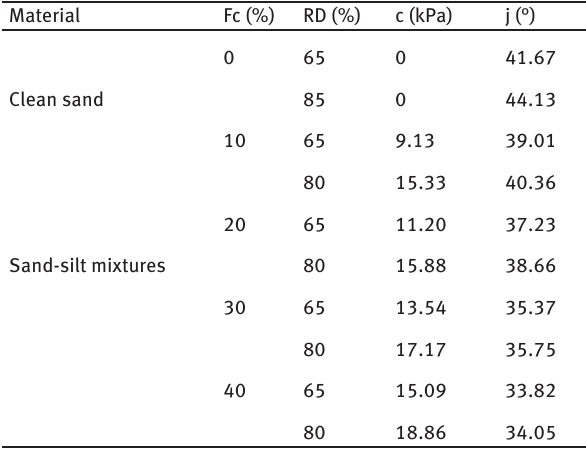
Figure 12: Effect of water content on the mechanical behaviour of clean sand (RD = 65%, σ versus horizontal displacement, (b) variation of vertical displacement versus horizontal Table 3: Cohesion and friction angle for tests result.